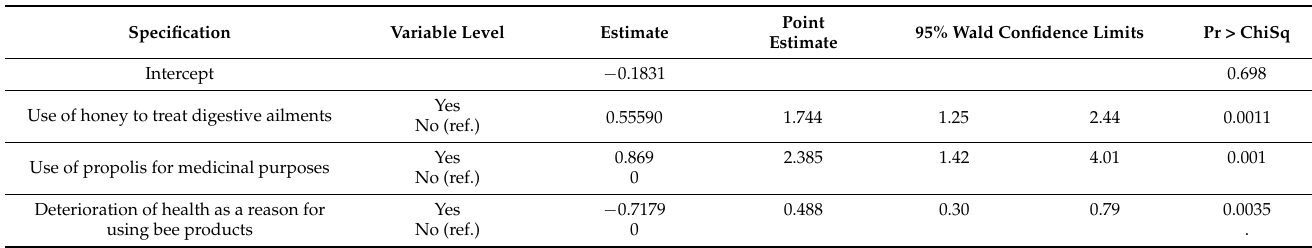
Table 9. Association of health status with bee products-related consumer behaviour (logistic regres- sion